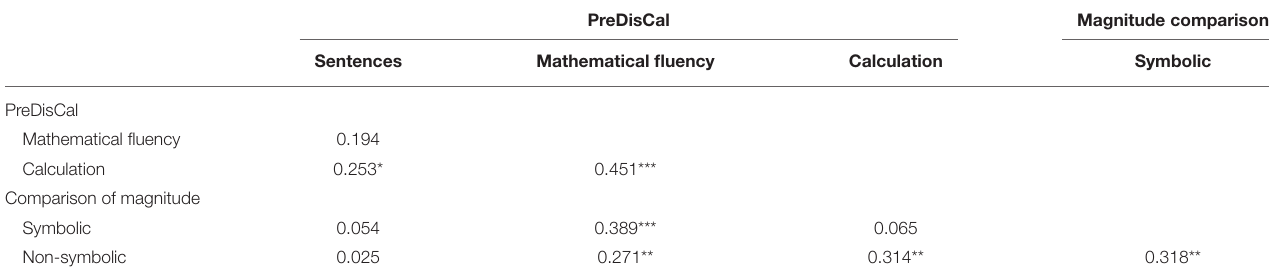
TABLE 2 | Spearman’s correlations between the PreDisCal and magnitude comparison (third grade